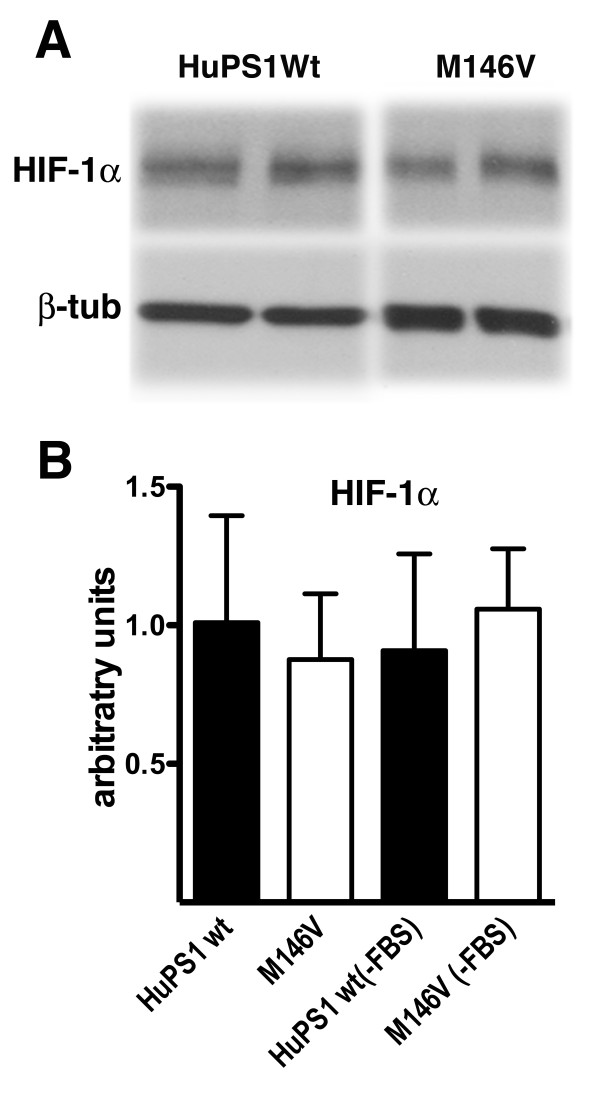
Basal levels of HIF-1α are unchanged in M146V FAD mutant fibroblasts. Shown are prolonged exposures of Western blots from the fibroblast lines studied in Figure 11. In panel A, representative blots are shown of samples from individual cultures harboring the human wild type Psen1 (HuPS1Wt) or the M146V FAD mutant. The lower panel shows the blot reprobed for β-tubulin. In panel B, levels of HIF-1α were determined by quantitative Western blotting (n = 5 cultures per genotype) with the levels of HIF-1α normalized to the levels of β-tubulin. Studies were performed both in the presence of serum (FBS) and after overnight serum starvation (-FBS). There were no statistically significant differences between the HuPS1Wt and M146V FAD mutant cell lines.